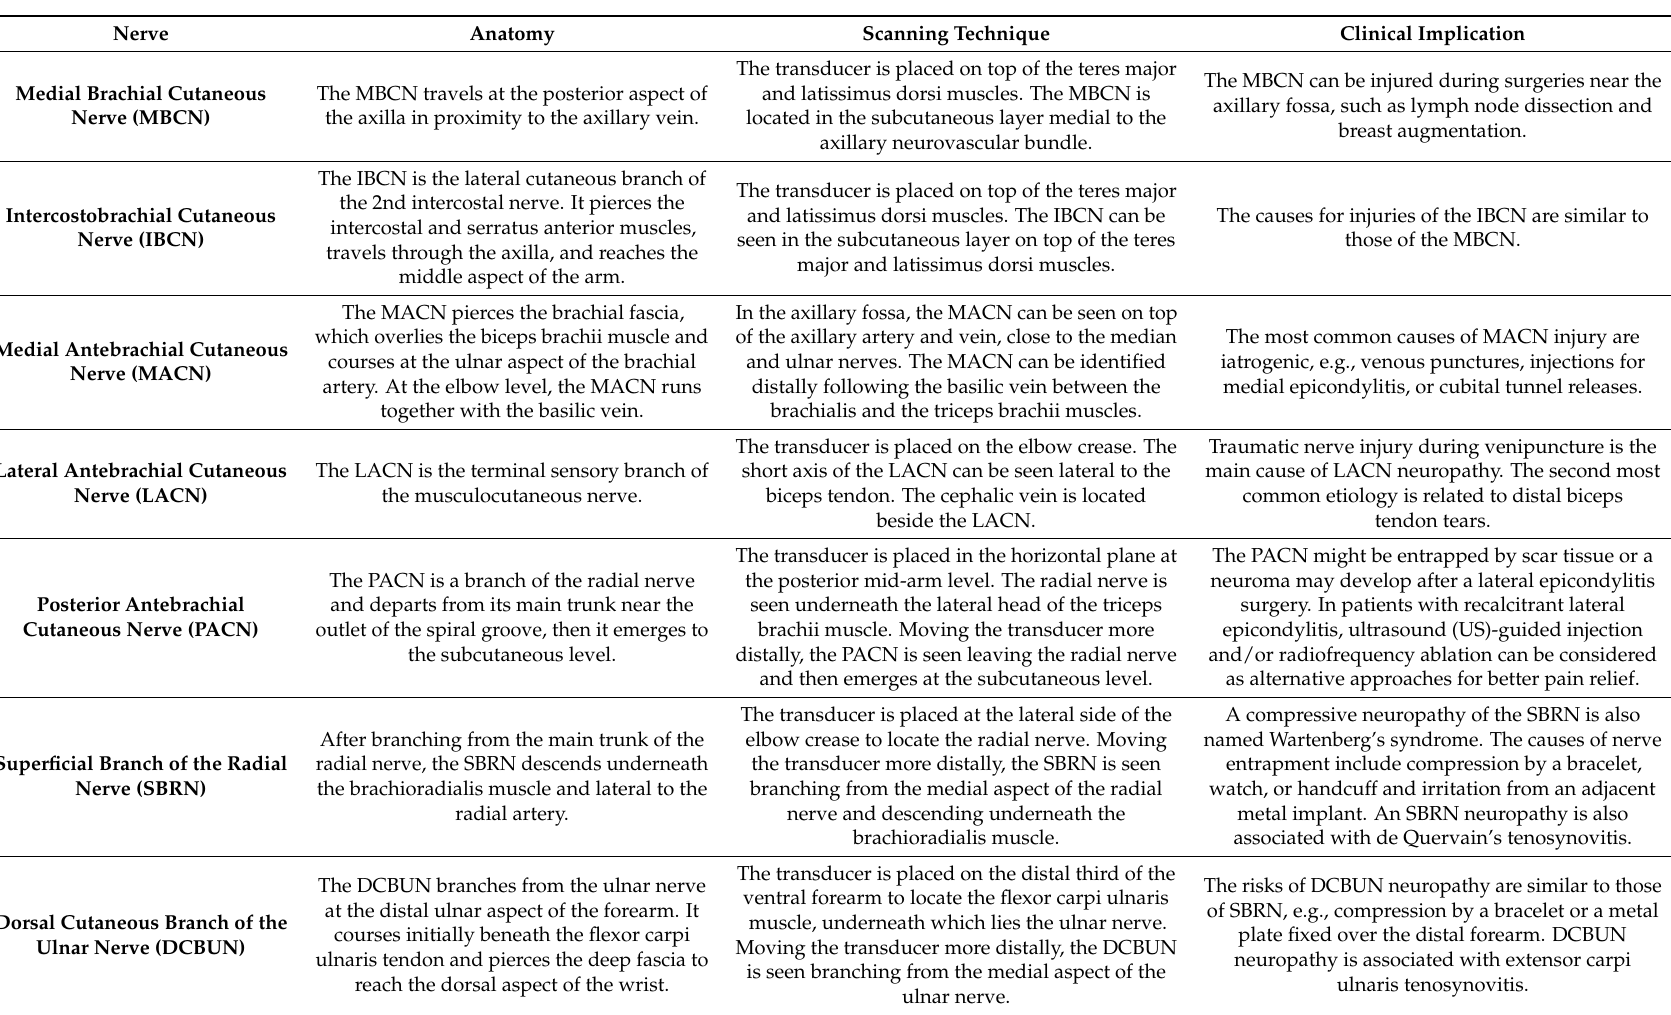
Table 1. A summary of anatomy, scanning techniques, and clinical implications of the extremity cutaneous